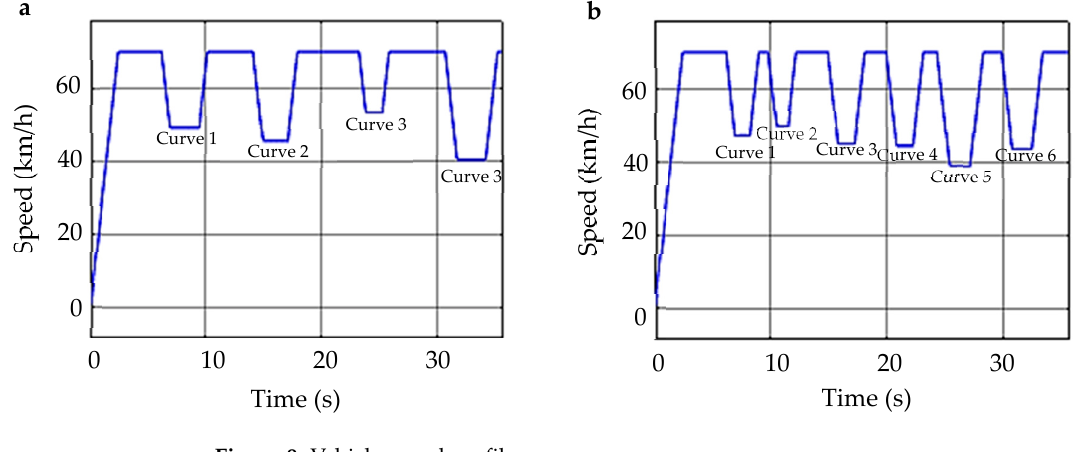
Figure 9. Vehicle speed profiles.